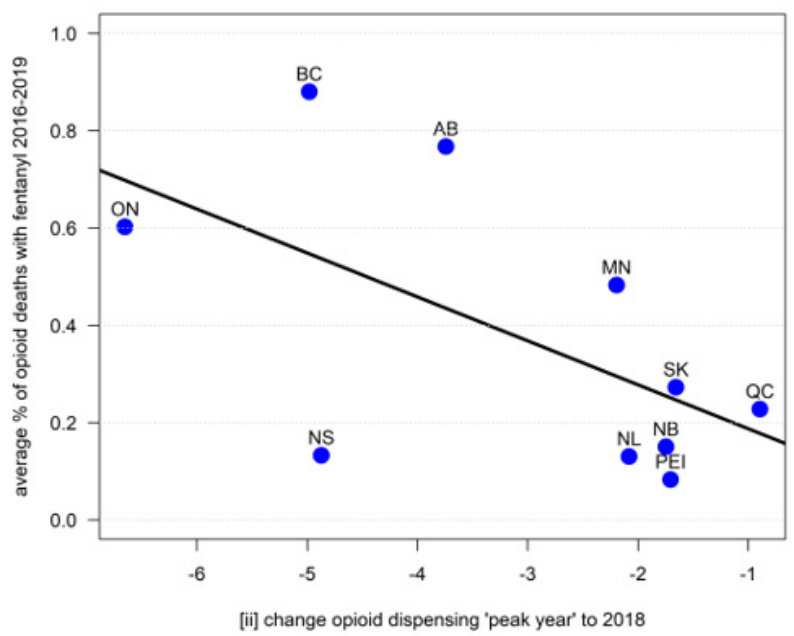
Figure 2. Correlations between opioid dispensing change (( i ) 2011 to 2018 and ( ii ) “peak-year” to 2018) in DDD/1000 population/day and average percent of opioid deaths involving fentanyl (2016 to 2019), by province in Canada (for abbreviations of provinces see Table 1) .